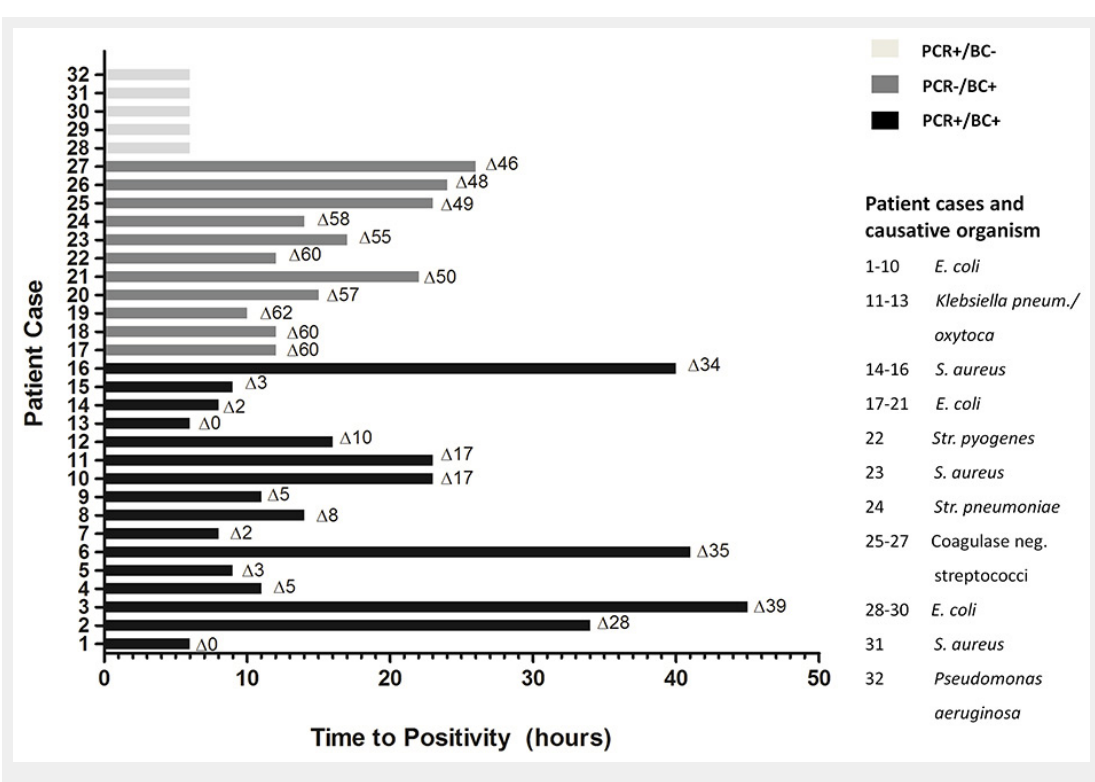
Figure 1 Time to positivity of the MRT-PCR and blood cultures. Time to positivity (TTP) of blood cultures (BC) in the 32 patients who were either positive with BC alone (PCR‒/BC+) or MRT-PCR alone (PCR+/ BC‒) or positive with both BC and MRT-PCR (PCR+/BC+). The 72 patients which were negative with both (PCR‒/BC‒) are not displayed. TTP of MRT-PCR is 6 hours by definition. The difference (Δ hours) between TTP of BC and MRT-PCR and the causative organism are displayed in each patient. For example, if the BC was positive after 24 hours and the MRT-PCR was positive (thus after 6 hours), the ΔTTP was 18 hours. If the microbiological method was negative or positive only after 72 hours, we used a cut-off of 72 hours to calculate the